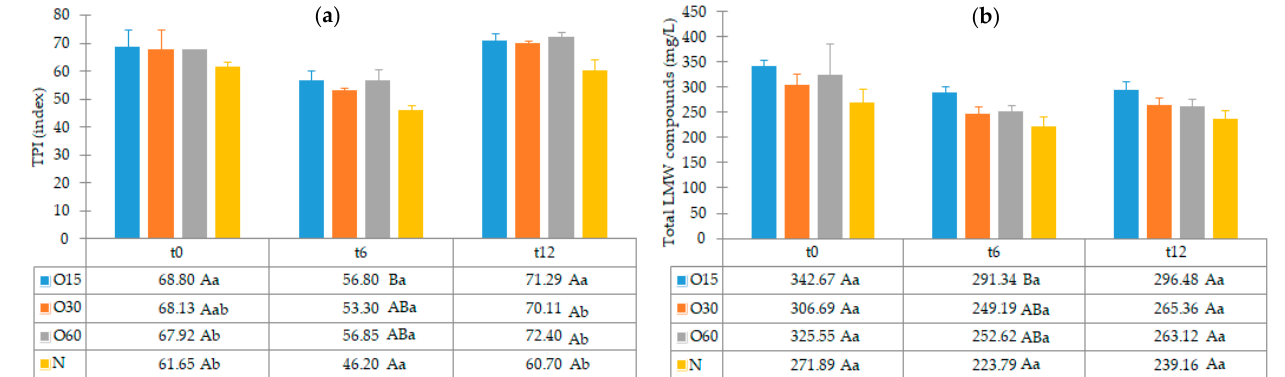
Figure 3. Average values of total phenolic index (TPI) and total LMW compounds in each storage time (0, 6, 12 months) according to ageing modalities (O15, O30, O60 and N): ( a ) TPI values; ( b ) Total LMW compounds content (calculated by summing the mean values of all compounds determined by HPLC method). Results are expressed as mean values ± standard deviation ( n = 4). For each analytical determination: different uppercase letters (A, B) in the same column denote significant differences between ageing modalities in each storage time by Tukey’s test ( p < 0.05); different lowercase letters (a, b) in the same row denote significant differences between storage times for each ageing modality by Tukey’s test ( p < 0.05).